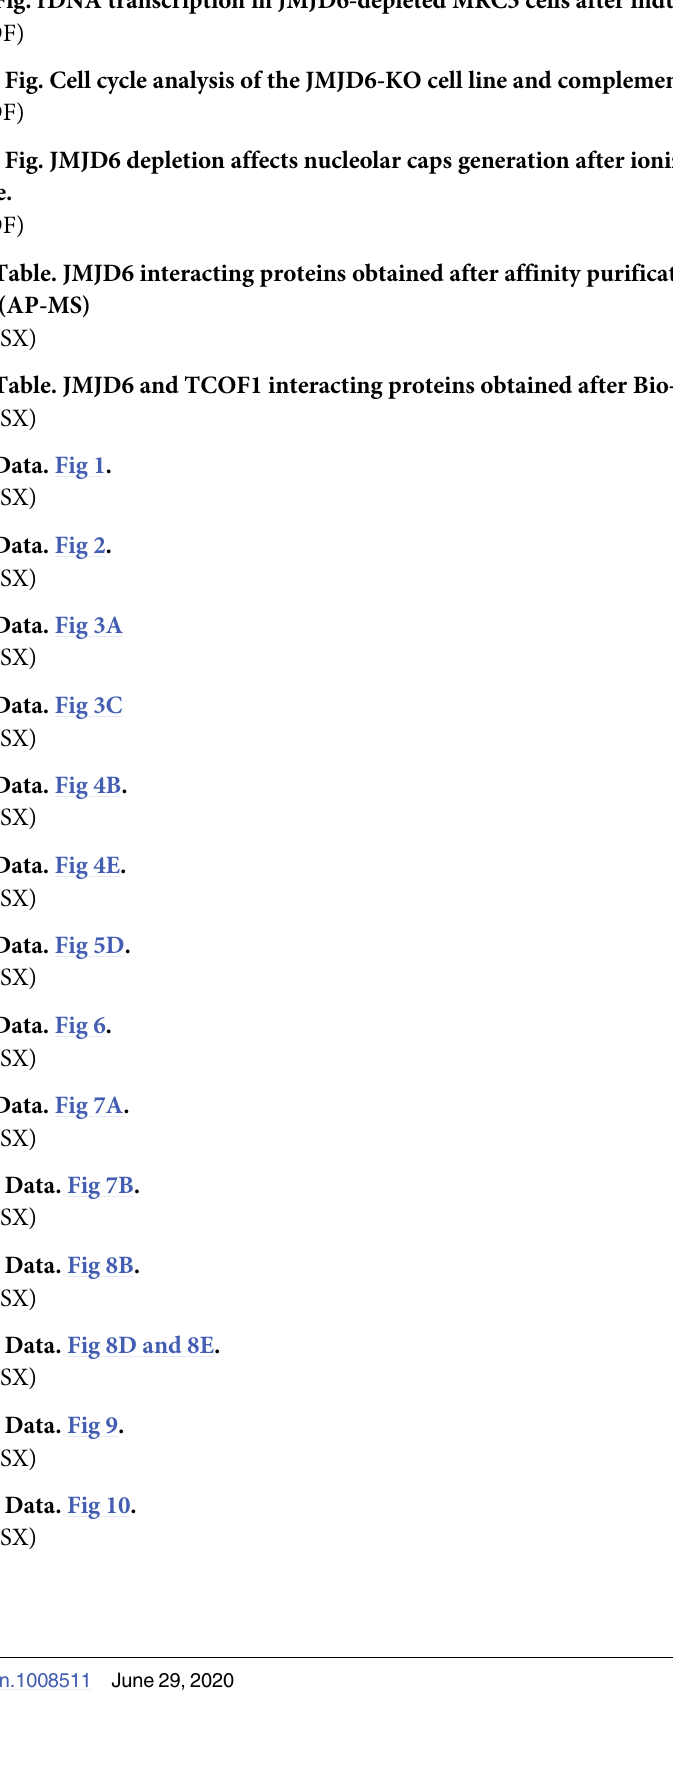
S1 Table. JMJD6 interacting proteins obtained after affinity purification-mass spectrome-